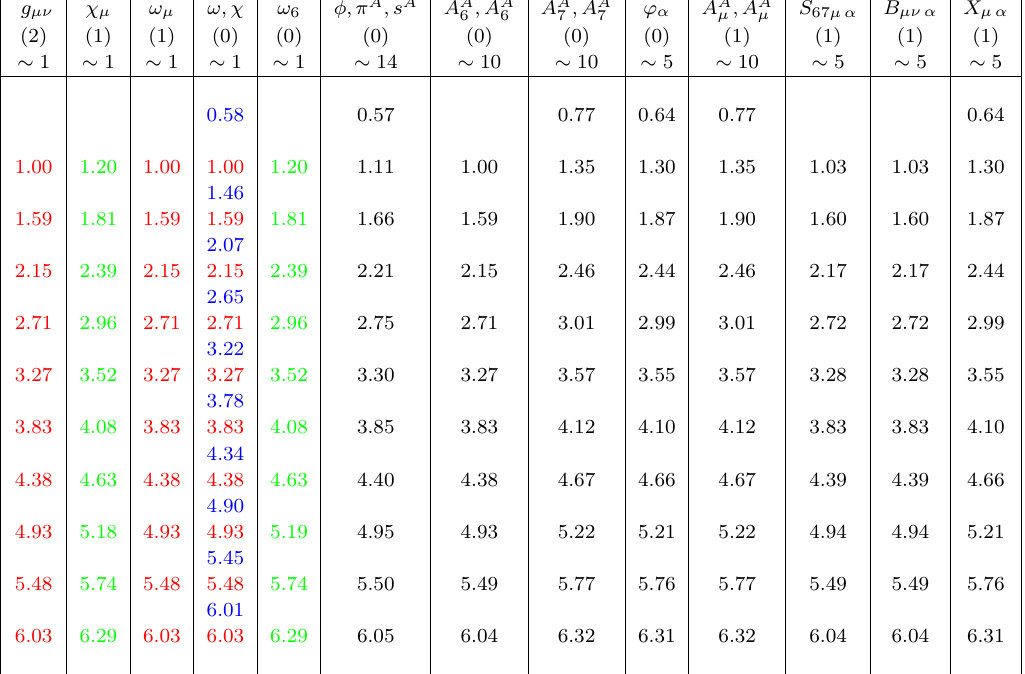
Table 3 . Numerical results for the spectrum of masses M n , normalised to the lightest tensor, of fluctuations computed in this paper, in the case of SO(5) symmetry, which is recovered when φ I = 0 . We put in bracket the spin ( J = 0 , 1 , 2) of the states and we explicitly indicate the SO(5) multiplets ∼ 1 , 5 , 10 , 14 . We highlight in red, green and blue, respectively, the SO(5) singlet states that appear also in our own results (see table 2 for comparison). Our original contribution is in the non-singlet